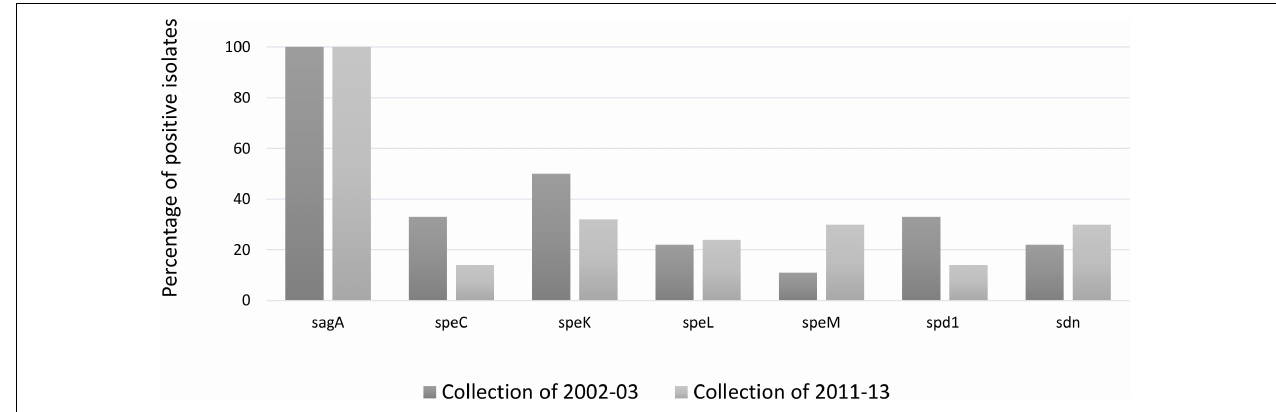
FIGURE 2 | Distribution (%) of group A Streptococcus pyogenes virulence gene among Streptococcus dysgalactiae subsp. dysgalactiae collections isolate in 2002–2003 and 2011–2013. speC , speK , speL , speM : encode streptococcal pyrogenic exotoxins; spd1 : DNase; sdn : streptodornase (DNase). The statistical significance of the data was determined by a chi-square test ( χ 2 ), where a probability value ( p ) ≤ 0.05 was considered as statistically significant.